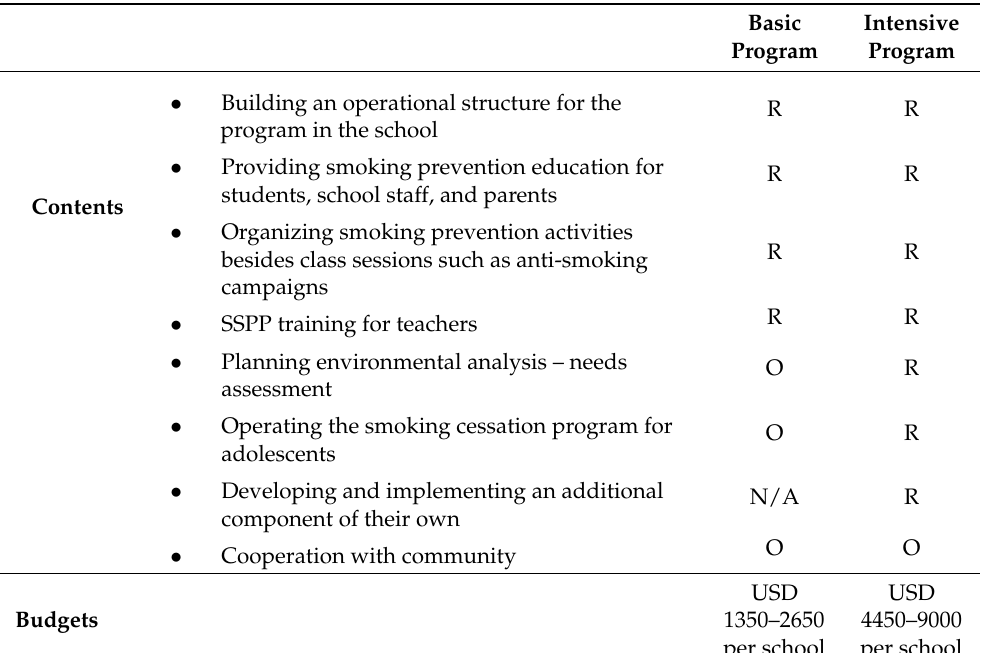
Table 1. Intervention characteristics according to program